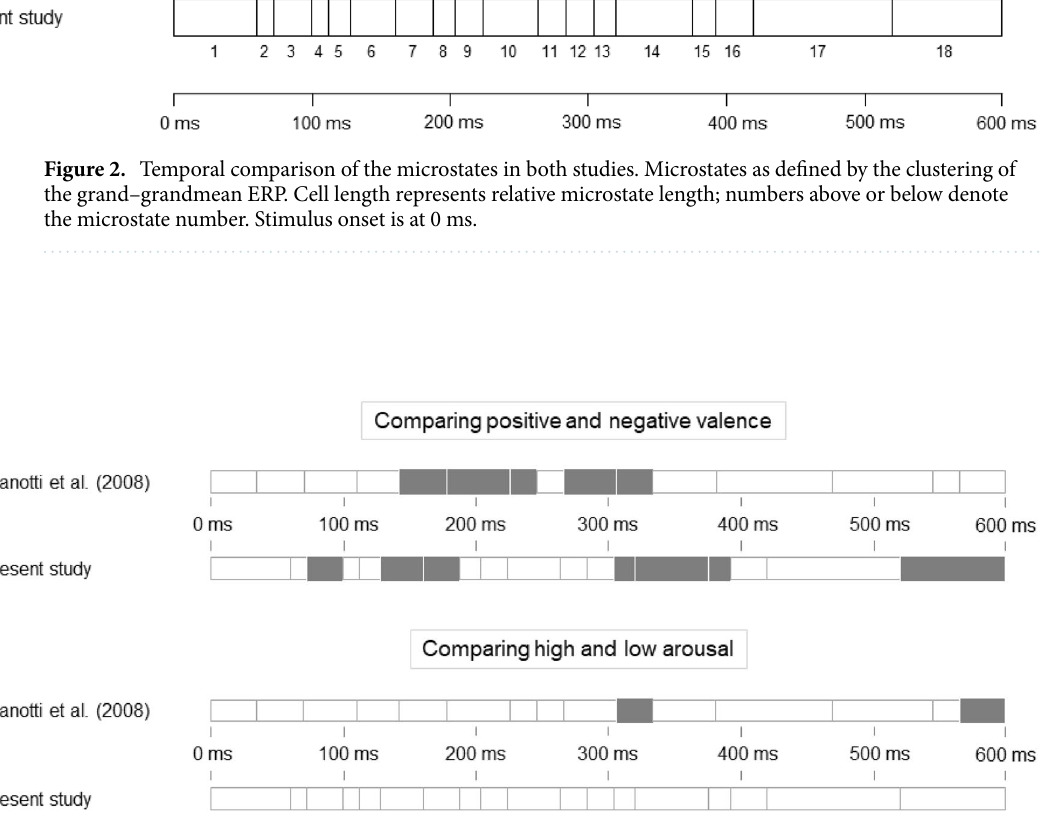
Figure 3. Side by side comparison of the significant microstates in the Active Viewing block of both studies. The upper panel shows the microstates with significant results in the TANOVA of negative and positive pictures in the Active Viewing block, the lower panel the ones of the TANOVA of highly and less emotionally arousing pictures in the Active Viewing block. Cell length represents the relative microstate length; colored cells are significant microstates. Stimulus onset is at 0